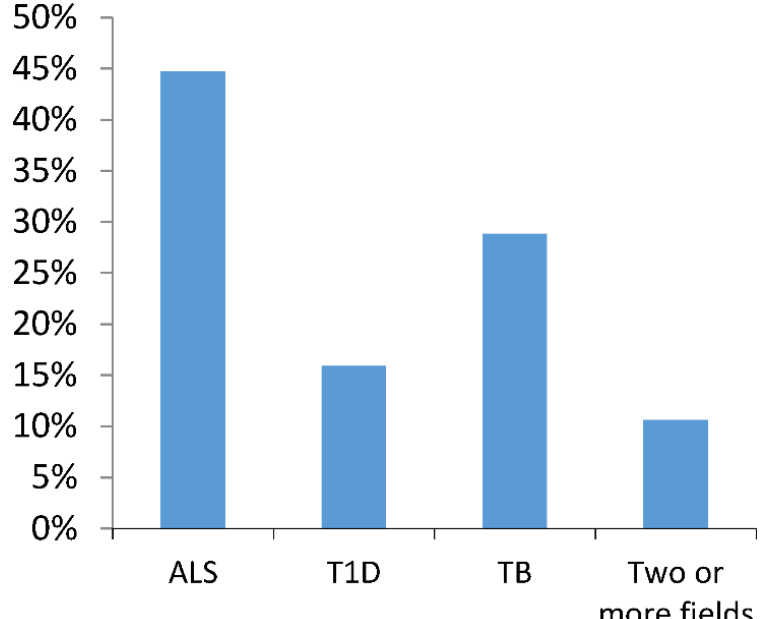
Figure 2. Topics covered by the journals in the sample (of the three selected).